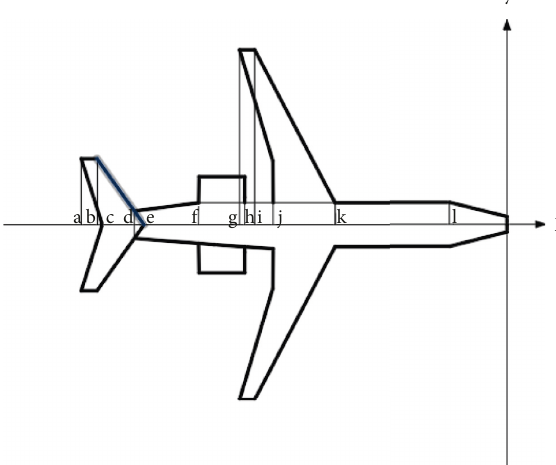
Figure 6: Schematic diagram of stress calculation model of cross wake vortex.